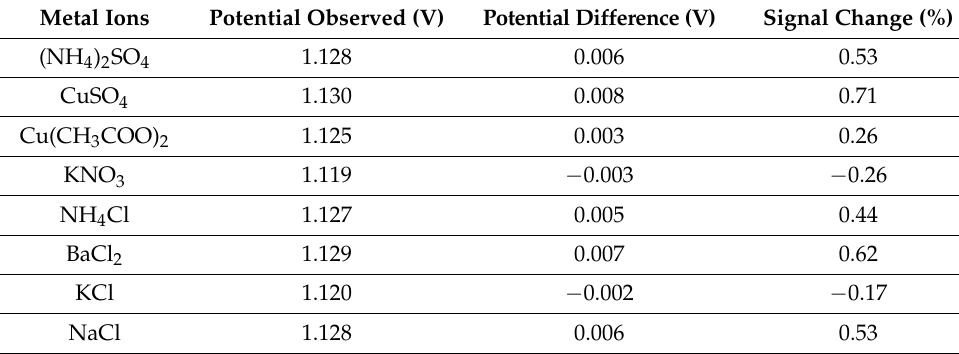
Table 2. Metal ion study on